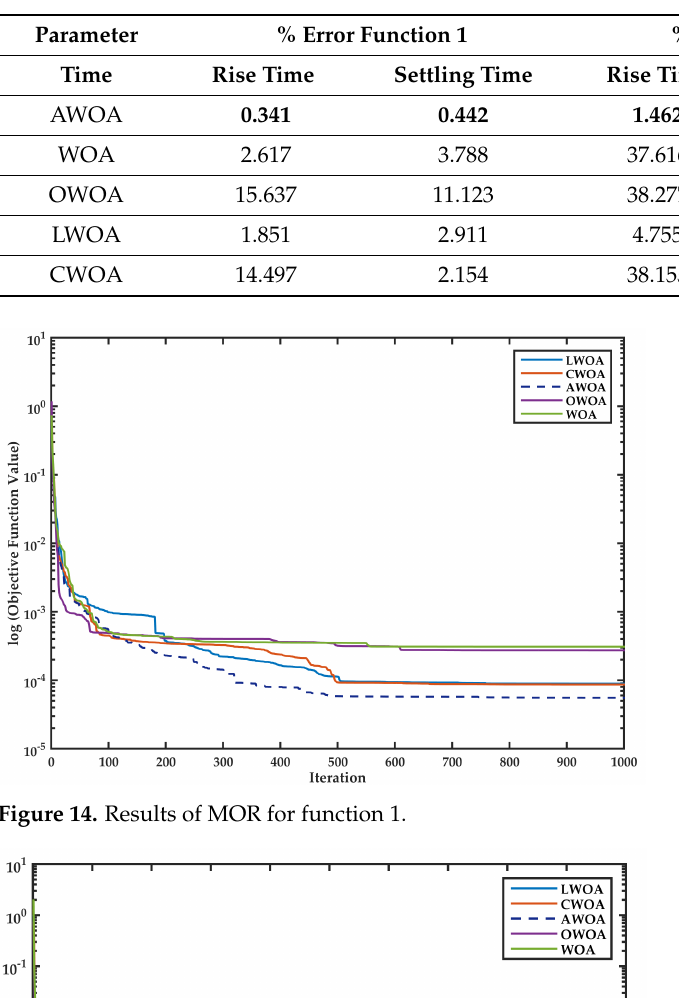
Table 11. Error analysis of MOR results on both functions.